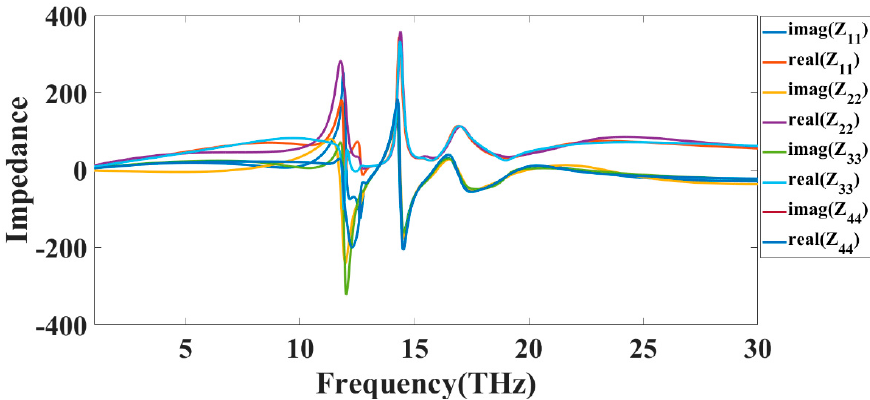
Figure 11. Calculated real and imaginary impedance values of the proposed MIMO antenna.